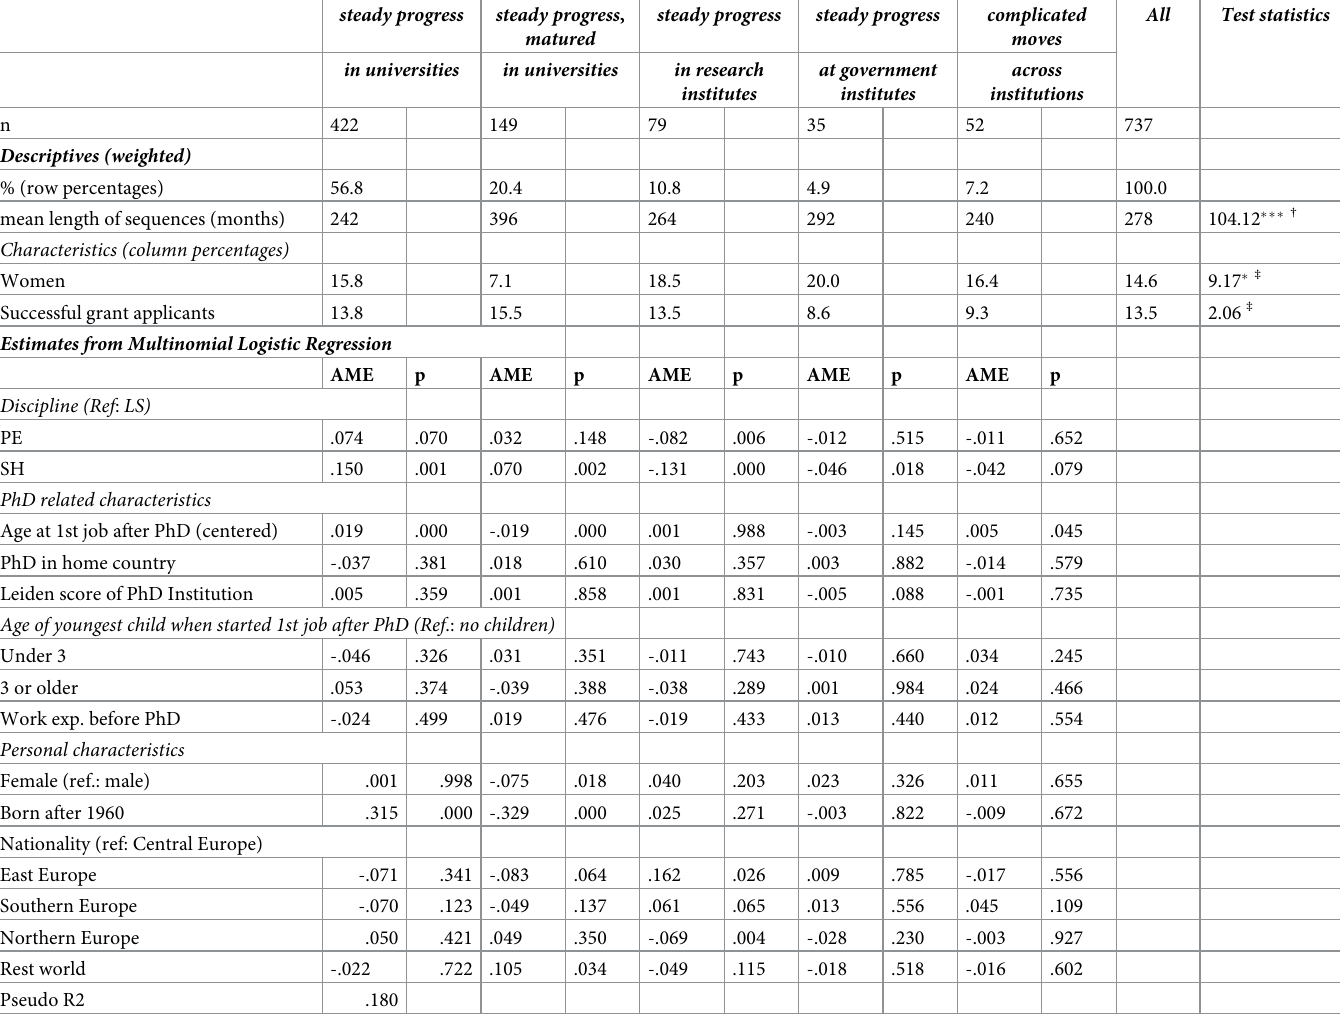
Table 3. Researchers in the Advanced Grant (AdG) patterns (descriptives, multinomial logistic regressions, average marginal effects). steady progress steady progress ,